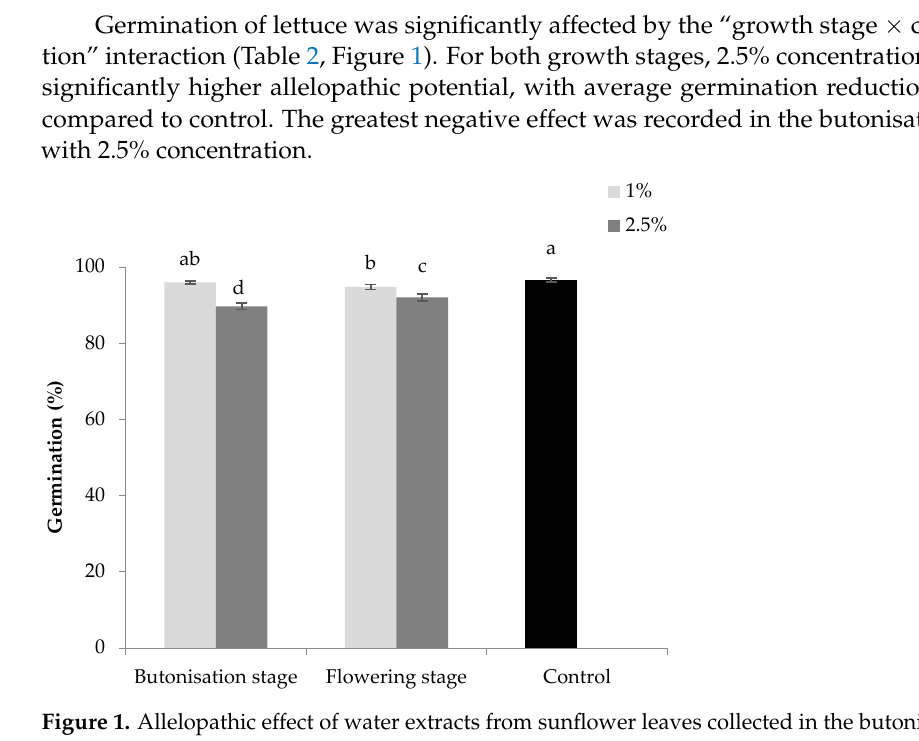
Figure 1. Allelopathic effect of water extracts from sunflower leaves collected in the butonisation and flowering stage on the germination of lettuce. Columns with the same letters are not signifi-